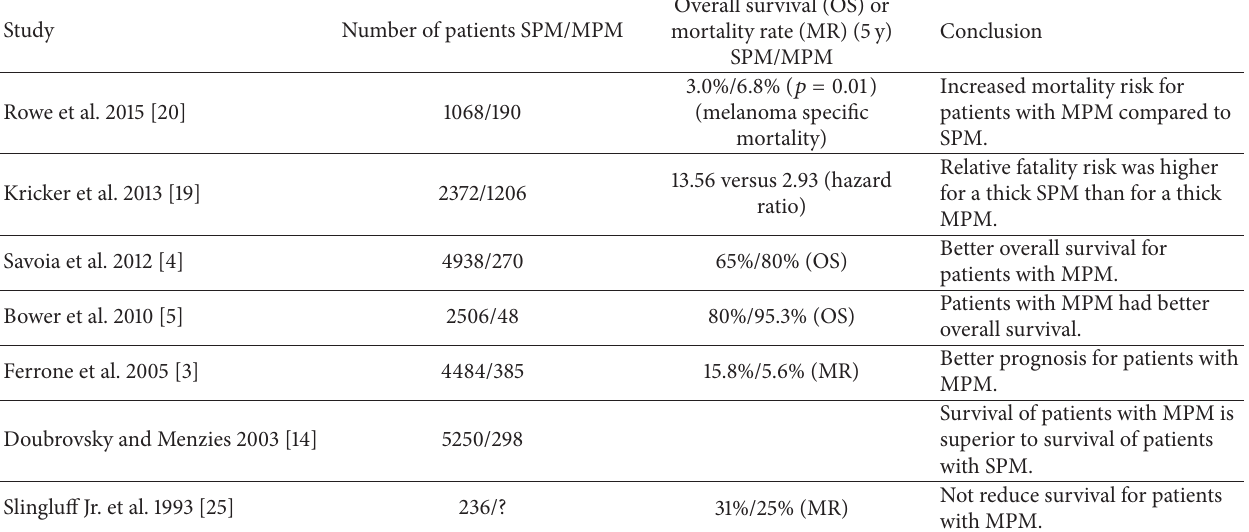
Table 4: Survival of patients with single or multiple primary